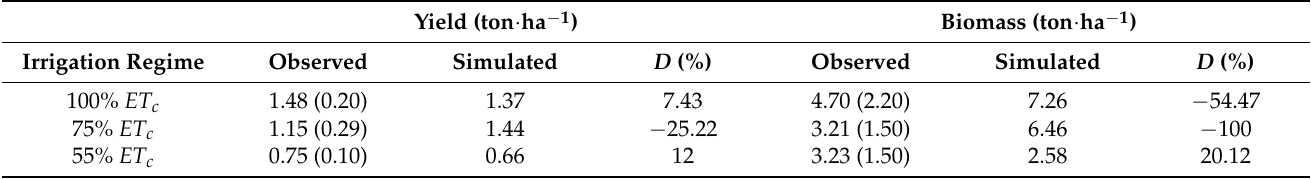
Table 9. Observed and simulated yield and final biomass during